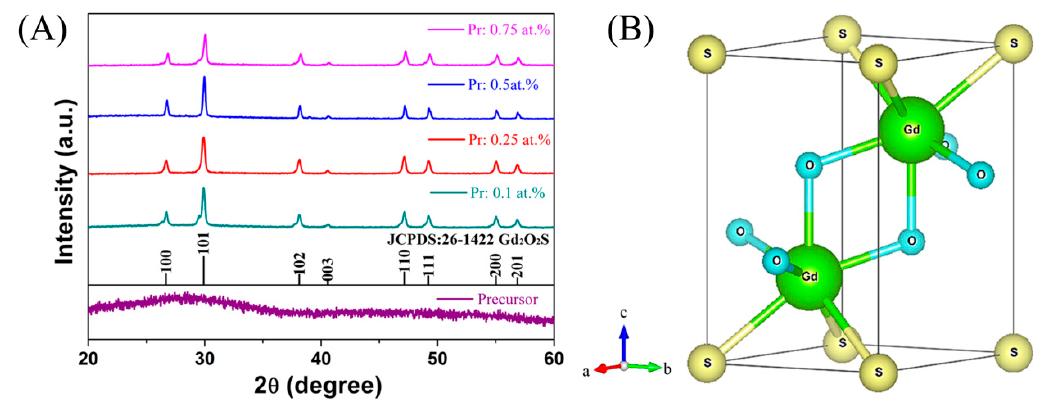
Figure 1. XRD patterns of the Gd 2 O 2 S (GOS):Pr precursor powder and reduction products ( A ), and schematic crystal structure of GOS ( B ).